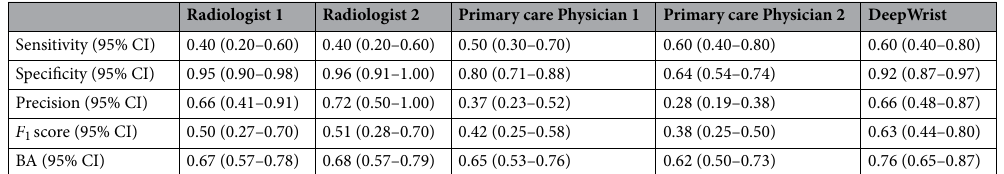
Table 4. Performance of 4 readers and DeepWrist on hard cases (test set #2). 95% confidence intervals (CI) are shown in parentheses. BA stands for balanced